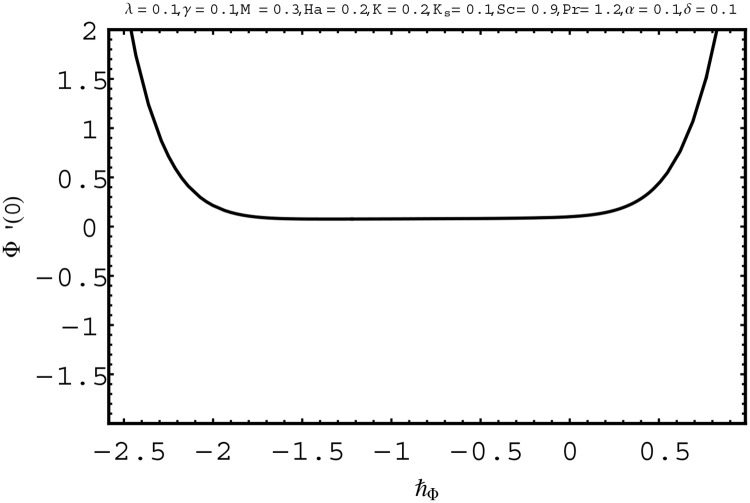
ℏ− curve for Φ(η).